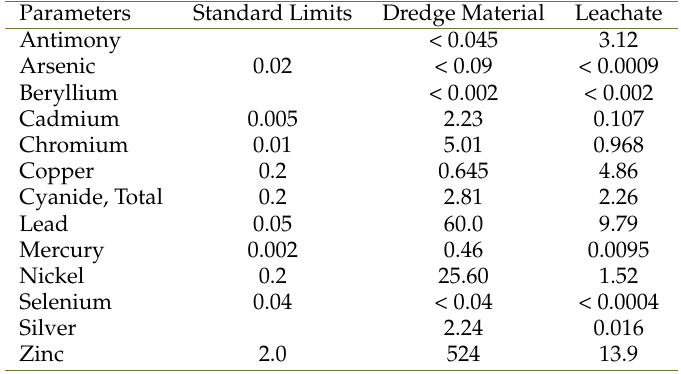
Table 3. The heavy metal content of dredged material and leachate (ppm) Parameters